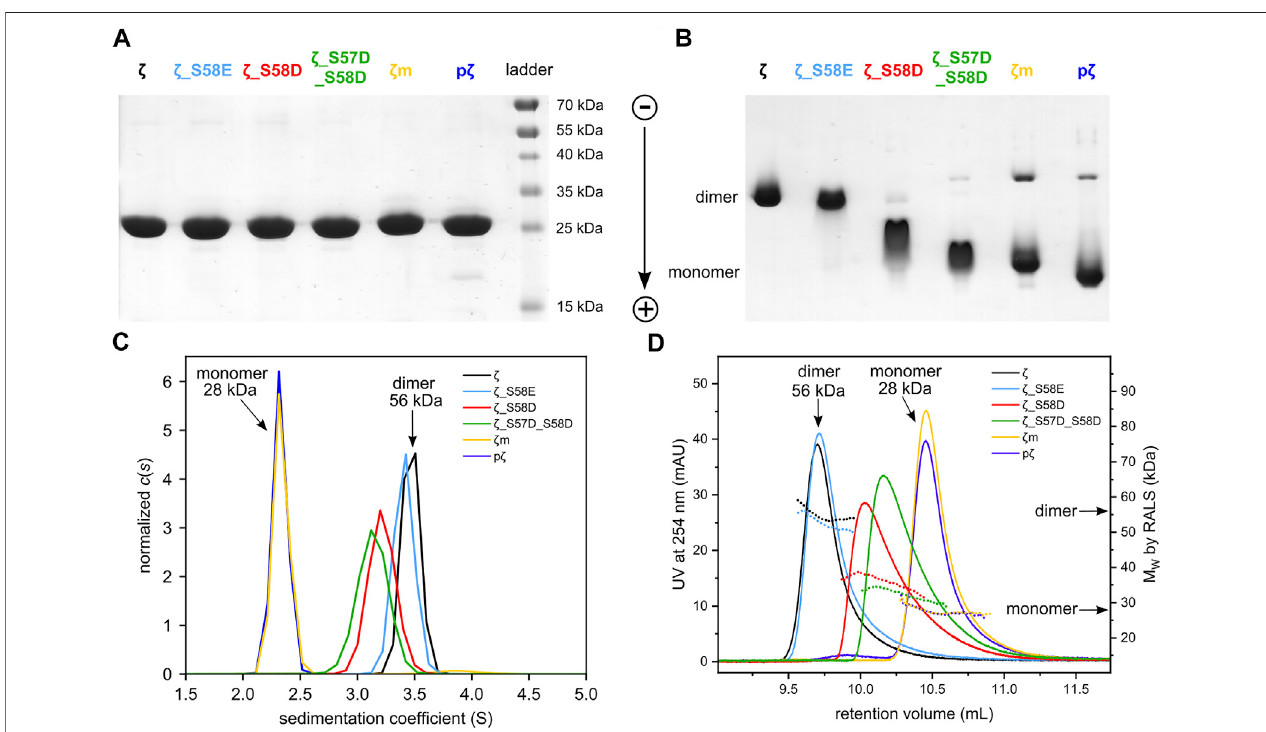
FIGURE 3 | Differences in oligomeric state between 14-3-3 ζ variants. (A) SDS-PAGE analysis of 25 μ M 14-3-3 ζ variants comparing their electrophoretic mobility under denaturing conditions, (B) native-PAGE of 25 μ M 14-3-3 ζ proteins, (C) AUC of 36.5 μ M 14-3-3 ζ proteins, (D) SEC-RALS of 36.5 μ M 14-3-3 ζ proteins.